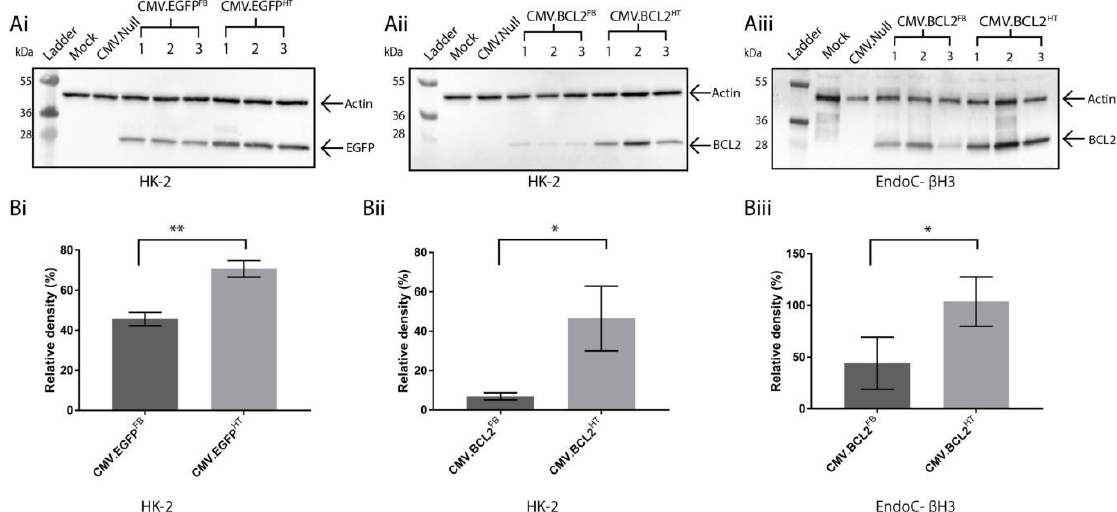
Figure 3. ( A ) immunoblot analysis of cell lysates following transduction with the named BacMam vector in HK-2 ( Ai , Aii ) or EndoC- β H3 ( Aiii ) cells at 72 hpt using anti-EGFP or anti-BCL2 antibodies. Molecular weight markers are in kDa. ( B ) A bar graph was constructed using GraphPad Prism to show the relative band intensities for ( Bi ) EGFP in HK-2, ( Bii ) BCL2 in HK-2 and ( Biii ) BCL2 in EndoC- β H3 cells obtained by band densitometry. Each sample was normalised against a β -actin loading control. Error bars represent ± SD ( n = 3) and indicate a significant difference between CMV.EGFP FB and CMV.EGFP HT , or CMV.BCL2 FB and CMV.BCL2 HT transduced cells using a Student’s t -test ( p < 0.05).